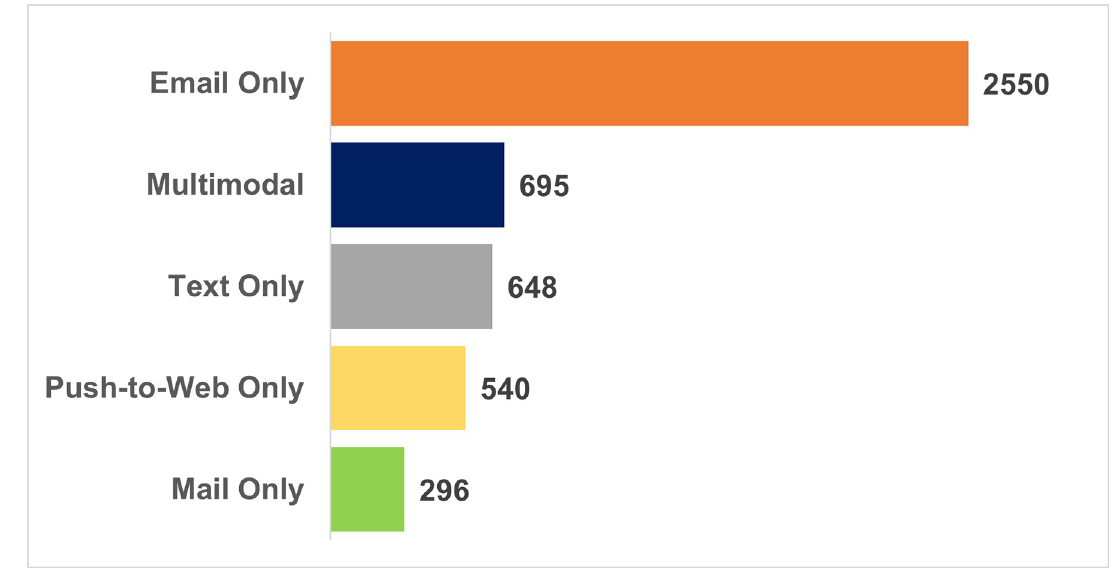
Fig 3. Invite mode that led to response across the six surveys (n =